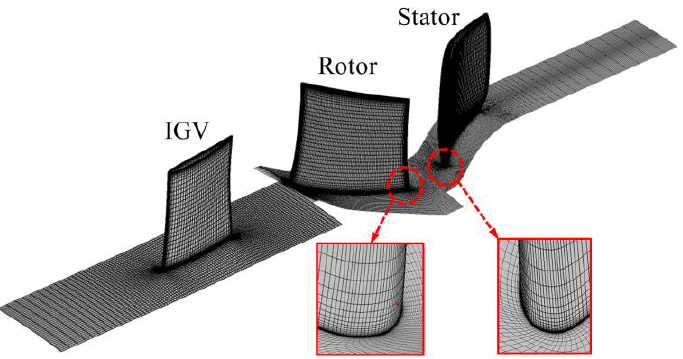
Figure 1. Geometry configuration and mesh for the compressor stage ( ψ = 0.41).